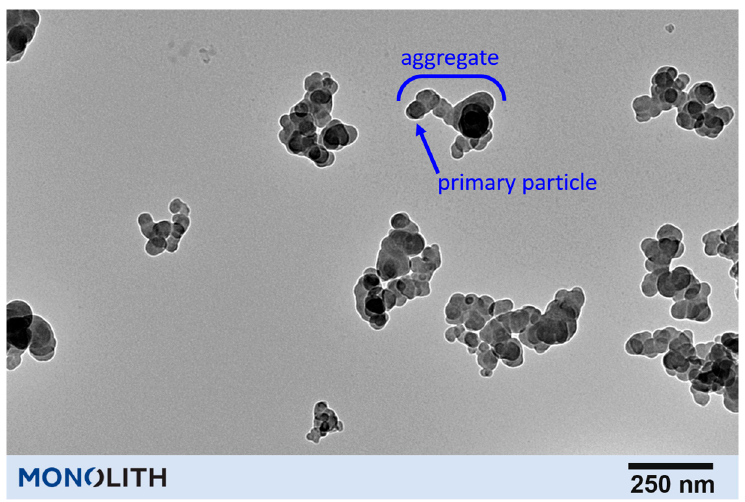
Figure 11. TEM image of N660 carbon black that shows the aggregates that are composed of smaller primary particles.